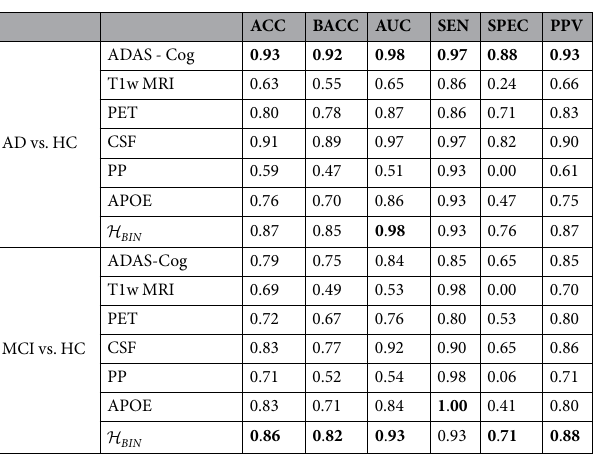
 ) modules of CaMCCo Table 7. Performance of the combined fusion (  ) and modality selection ( SMVCCA SEL  shows improvement over individual modality classifiers for MCI vs. HC, ). for binary classification (  BIN BIN particularly in terms of achieving the both high sensitivity and specificity. For AD vs. HC, several individual modalities have sufficiently high classification performance and thereby leaving no room for further  improvement with BIN